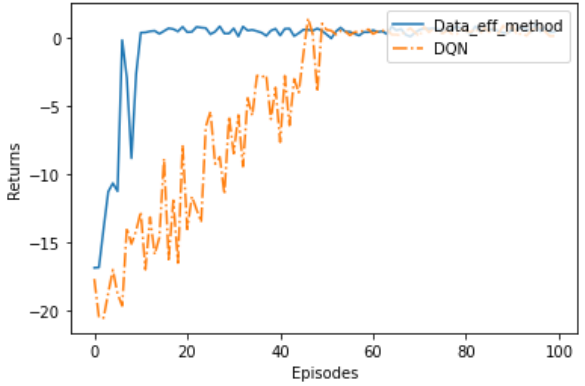
Figure 1. Learning curve of the toy experiment.